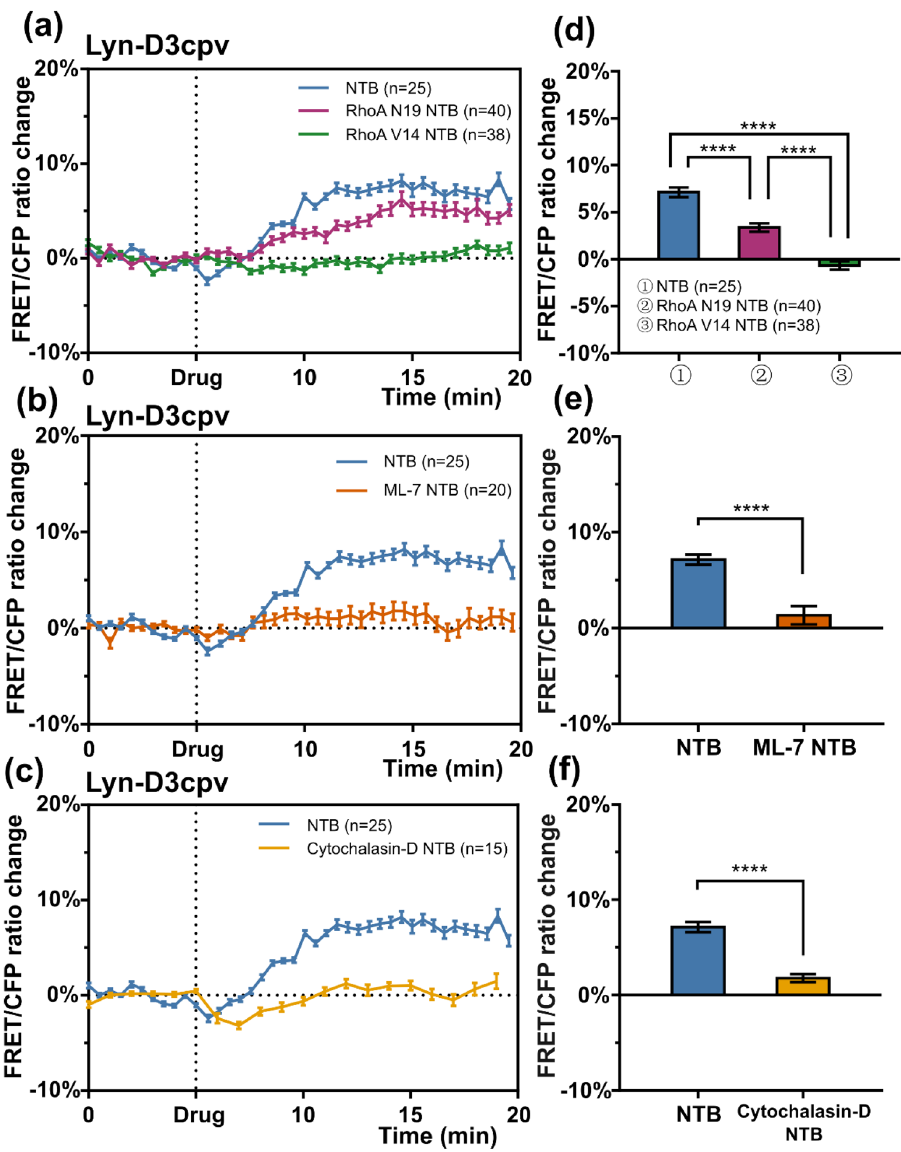
Figure 4. Graphs of the fluorescence resonance energy transfer (FRET)/enhanced cyan fluorescent protein (CFP) ratio change obtained with the Lyn-D3cpv biosensor. ( a ) Mutant RhoA lowered transient receptor potential subfamily M member 7 (TRPM7)-generated Ca 2+ influx. ( b ) Pretreatment with myosin light chain kinase inhibitor (ML-7) or ( c ) cytochalasin-D drugs halted TRPM7 activity. Bar plots with the values of the FRET/CFP ratio change 12 min after the beginning of the experiments; ( d ) from ( a ) (one-way analysis of variance, **** P < 0.0001); ( e ) from ( b ) (Student’s t test, **** P < 0.0001), ( f ) from ( c ) (Student’s t test, **** P < 0.0001). NTB, naltriben. n, number of cells. Error bars in the line plots represent the standard error of the mean ( P <